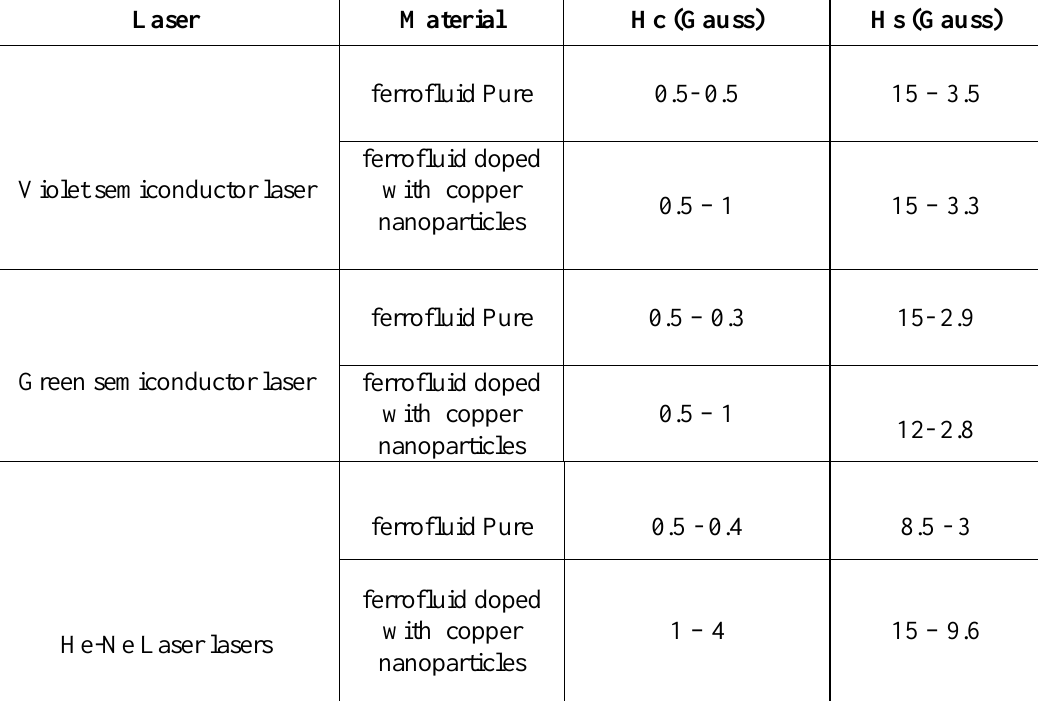
Table 1: The critical and the saturation magnetic field of the